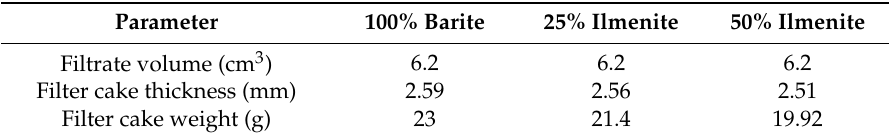
Table 5. Summary for HPHT filtration test